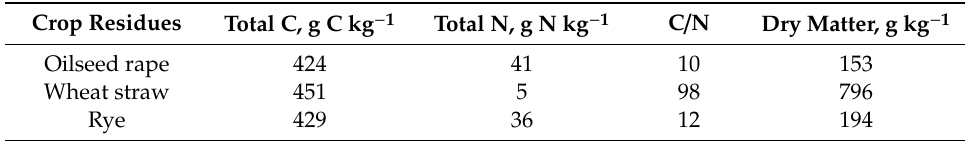
Table 2. Initial chemical properties of plant